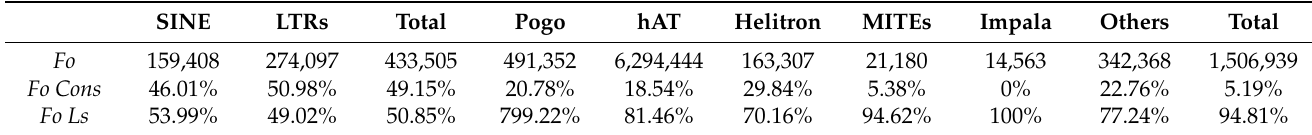
Table 2. Transposon elements (TEs) in F. oxysporum genome by Ma et al., 2010 [42]. SINE